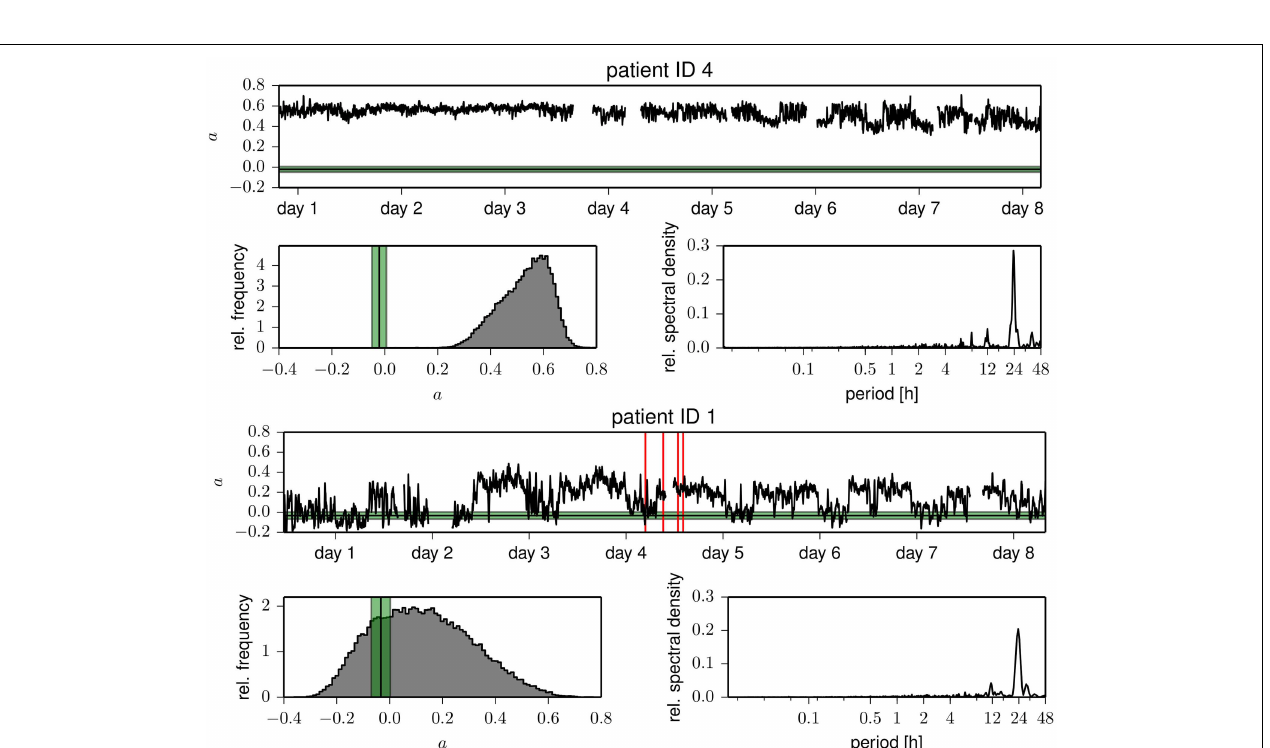
FIGURE 1 | Temporal evolutions of the assortativity coefficient of functional brain networks derived from patient 4 (upper part) and from patient 1 (lower part). Time profiles were smoothed using a moving average over 30 windows corresponding to 10.24min for better legibility. Discontinuities are due to recording gaps. Tics on x-axes denote midnight. Vertical red lines mark the times of electrical onset of seizures, and the horizontal black lines (standard deviation is shown in